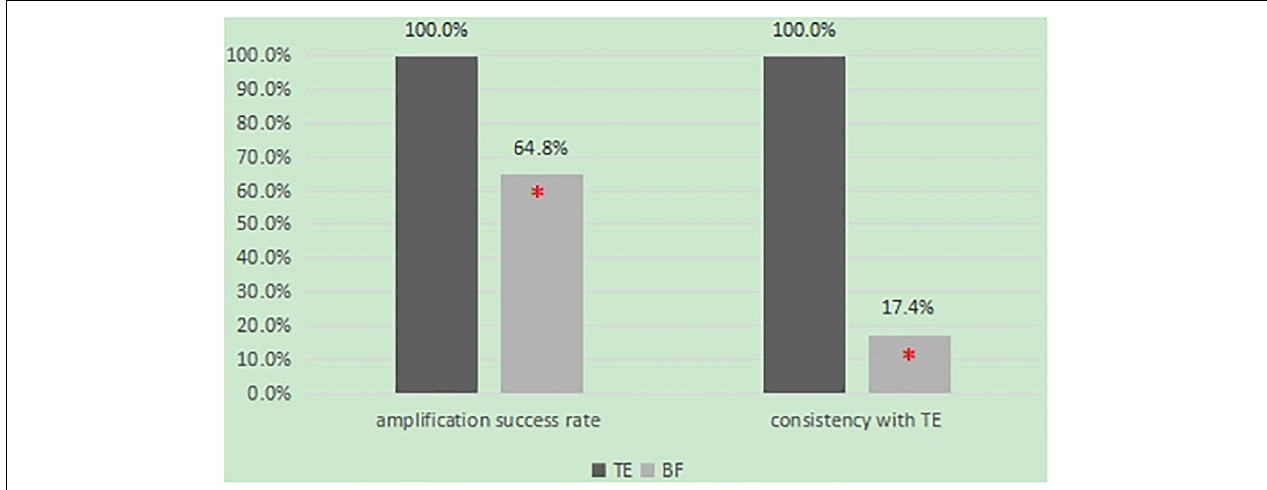
FIGURE 1 | The comparison of BF and TE in the amplication success rate and consistency.